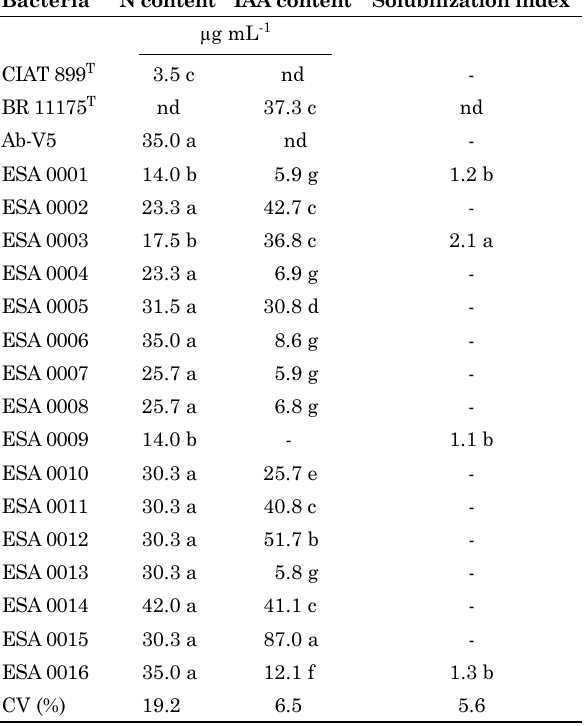
Table 2. nitrogen incorporation in the culture medium, in vitro indole-acetic acid production, and calcium phosphate solubilization by 16 bacterial isolates from Tripogon spicatus and reference strains. Data are means of three